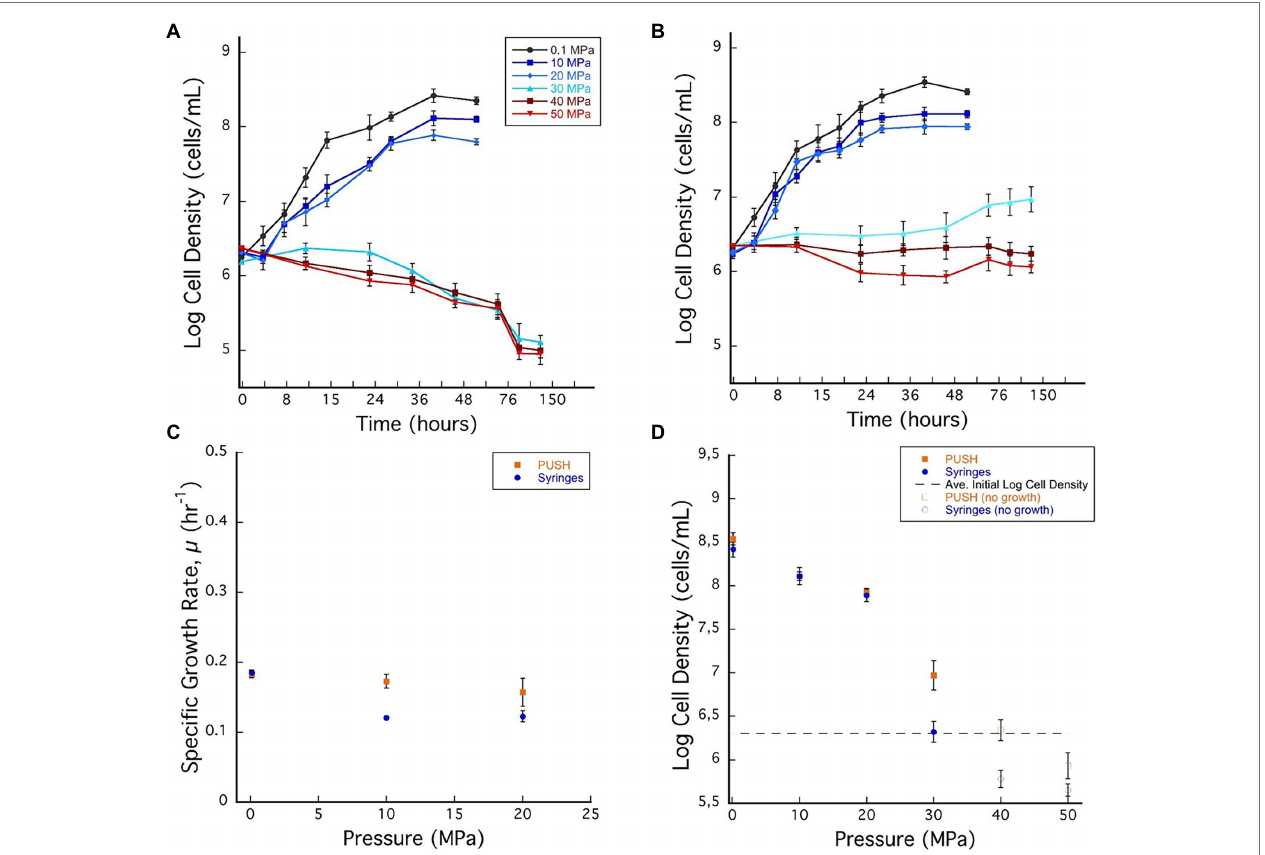
FIGURE 1 | (A) Desulfovibrio salexigens growth curves in plastic syringes with multiple sample decompression and (B) D. salexigens growth curves in the pressurized underwater sample handler (PUSH) vessels without multiple sample decompression from 0.1 to 50 MPa. (C) Desulfovibrio salexigens specific growth rates in the PUSH vessels (orange squares) and in syringes (blue circles). (D) Desulfovibrio salexigens maximum log cell densities in the PUSH vessels (orange squares) and in syringes (blue circles), open orange squares and blue circle indicate maximum cell densities in samples with no observed growth or observed cell densities lower than the average initial cell densities (dashed lines in D ). Error bars are the SDs from the average of triplicate experiments. Significant differences were determined by Student’s t -test (value of p <